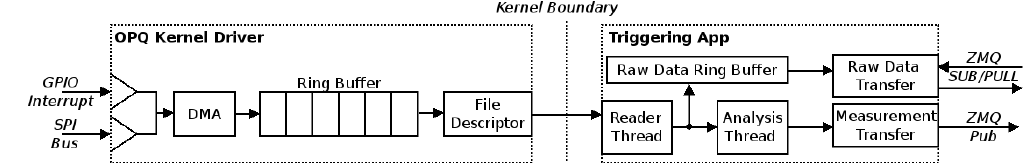
Figure 3. Block diagram of the OPQ Box 2 software